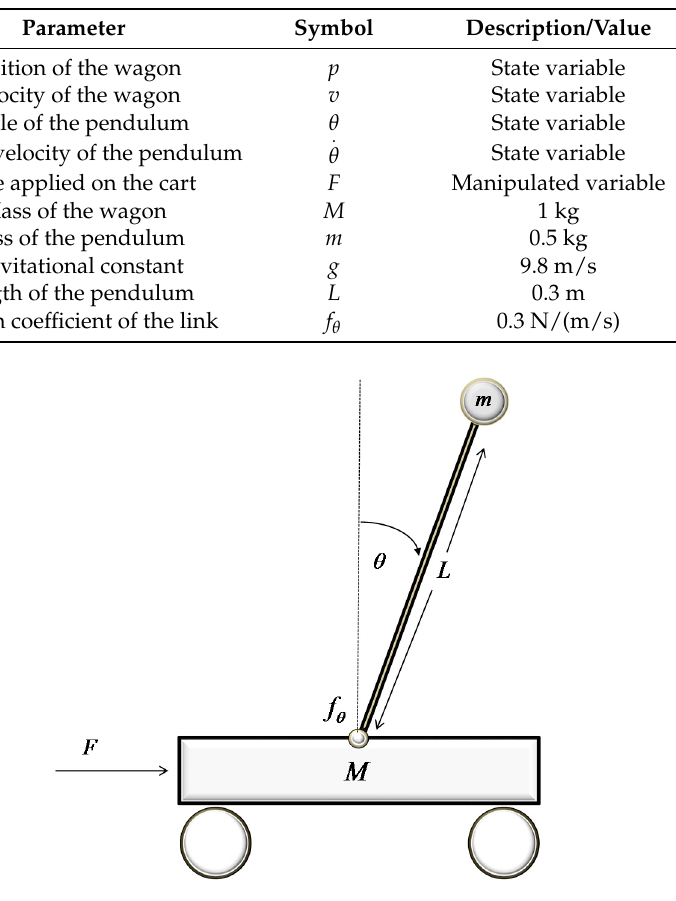
Figure 7. An inverted pendulum.